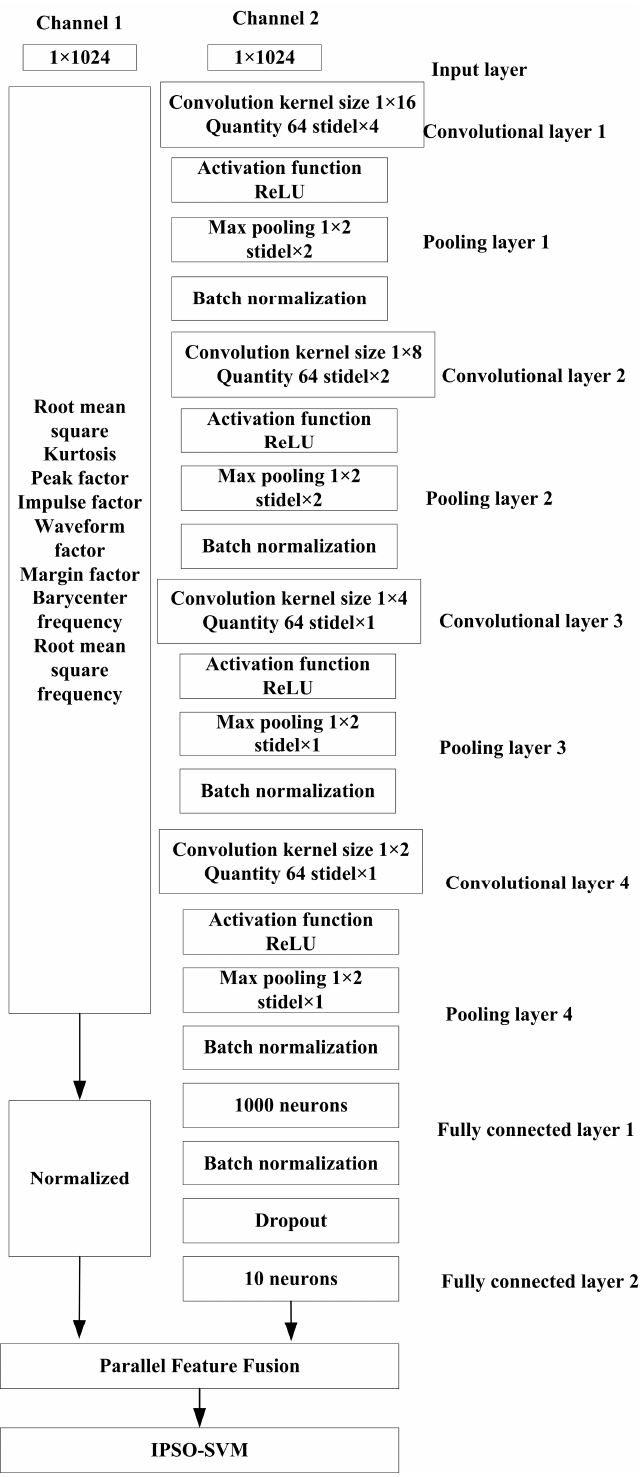
Figure 6. Parameter flow chart of the gearbox fault diagnosis based on parallel feature fusion.